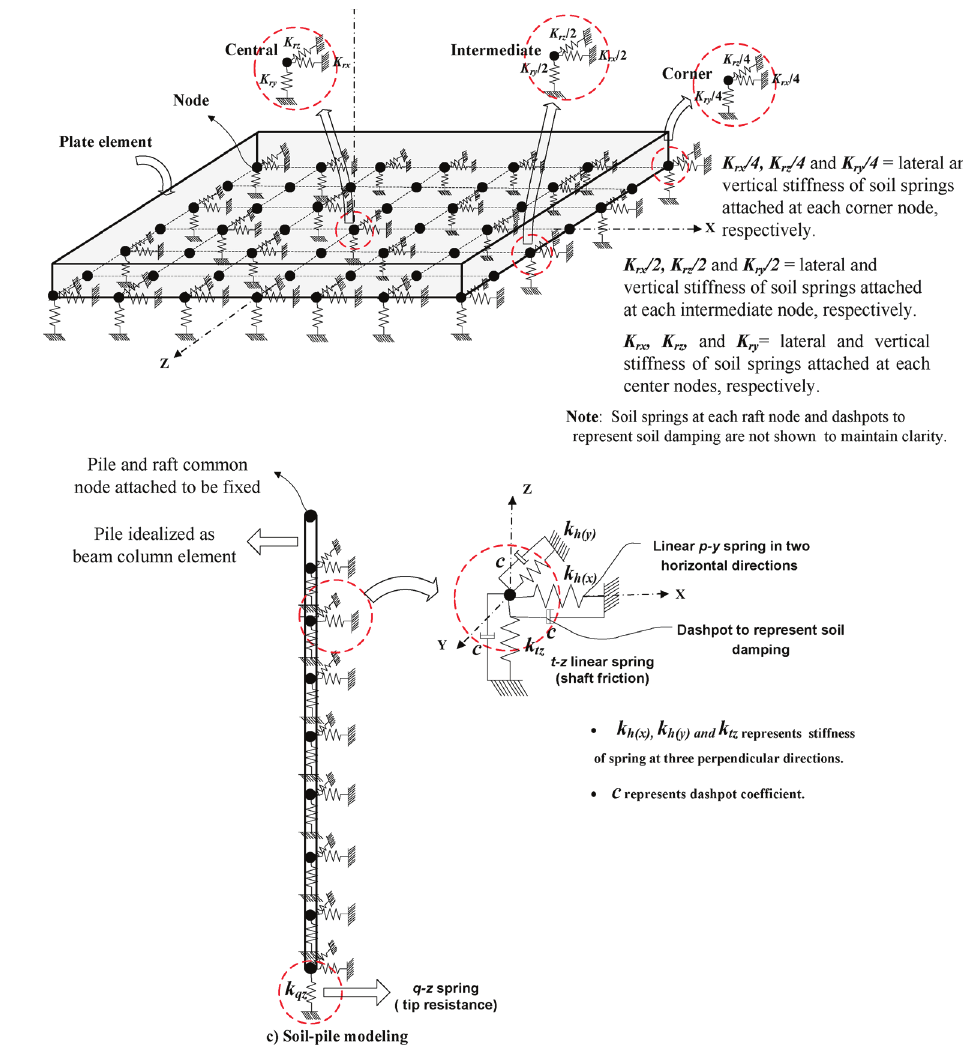
Fig. 3. Detailed representation of finite element model for (a) soil-raft and (b) soil-pile